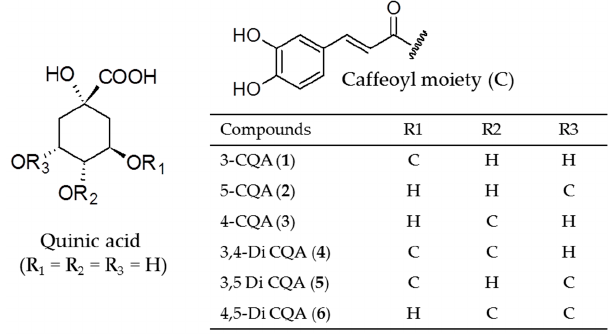
Figure 1. Structures of chlorogenic acids in sunflower extract.